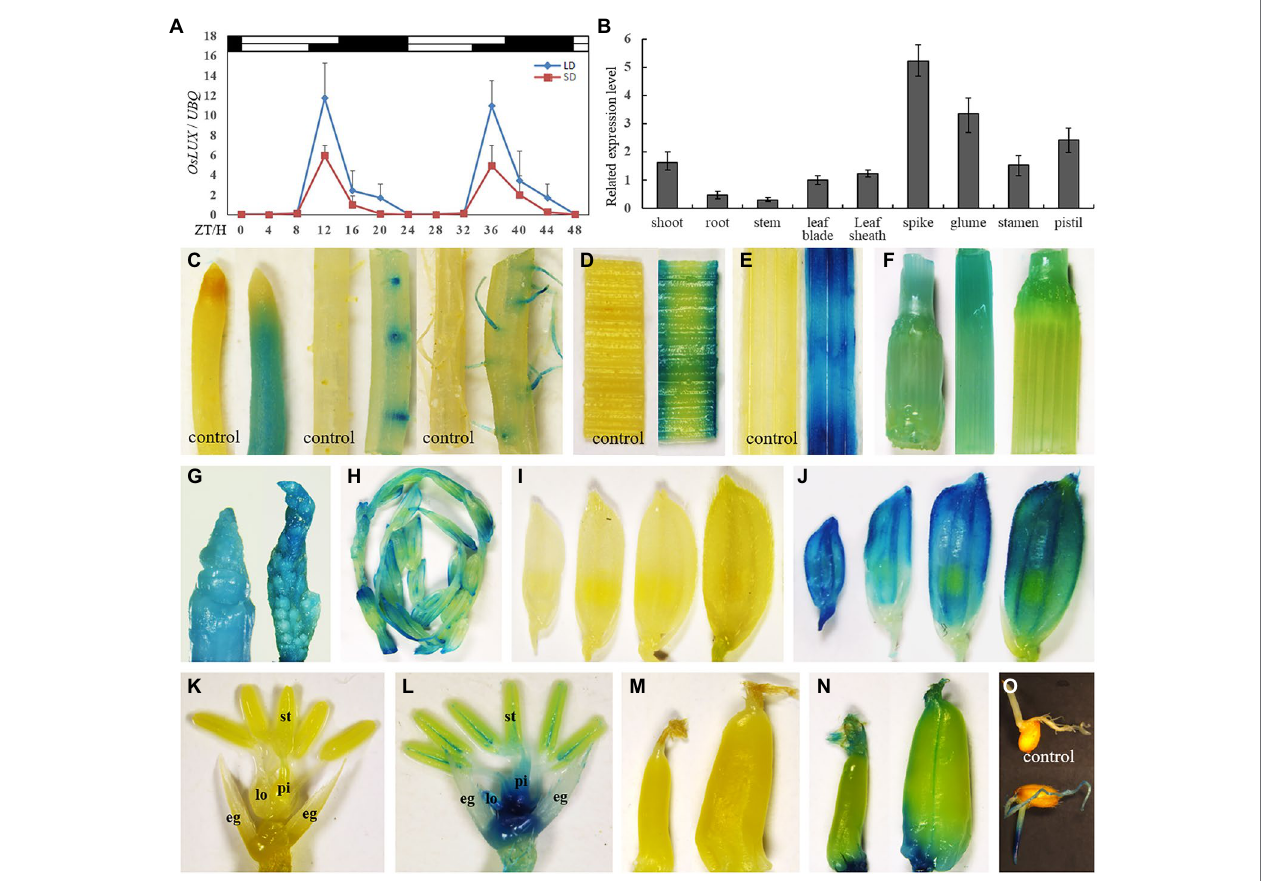
FIGURE 3 | qRT-PCR and GUS analyses of OsLUX expression pattern. (A) The rhythmic expression of OsLUX under both LD and SD conditions in Nipponbare. Rice leaves were collected at the indicated time points from 35- and 70-day-old plants grown under SD and LD, respectively. The expression levels are relative to the UBQ mRNA. Values and error bars are the mean and SD of three replicates. The white bars and black bars at the top represent the light and dark periods, respectively. ZT, Zeitgeber time. (B) OsLUX transcript accumulation in different tissues and organs. Values and error bars are the mean and SD of three replicates. (C–O) GUS detection of OsLUX transcript accumulation in roots of different parts or developmental stages (C) , young leaf blade (D) and leaf sheath (E) , stems of different parts or developmental stages (F) , young panicle (G,H) , developing spikelet (J) , floral organs with lemma and palea removed (L) , developing seed (N) , and the germ and radicle of germinating seed ( O) . (I) , (K) and (M) were controls. eg, extra glums; lo, lodicule; st, stamen; pi,